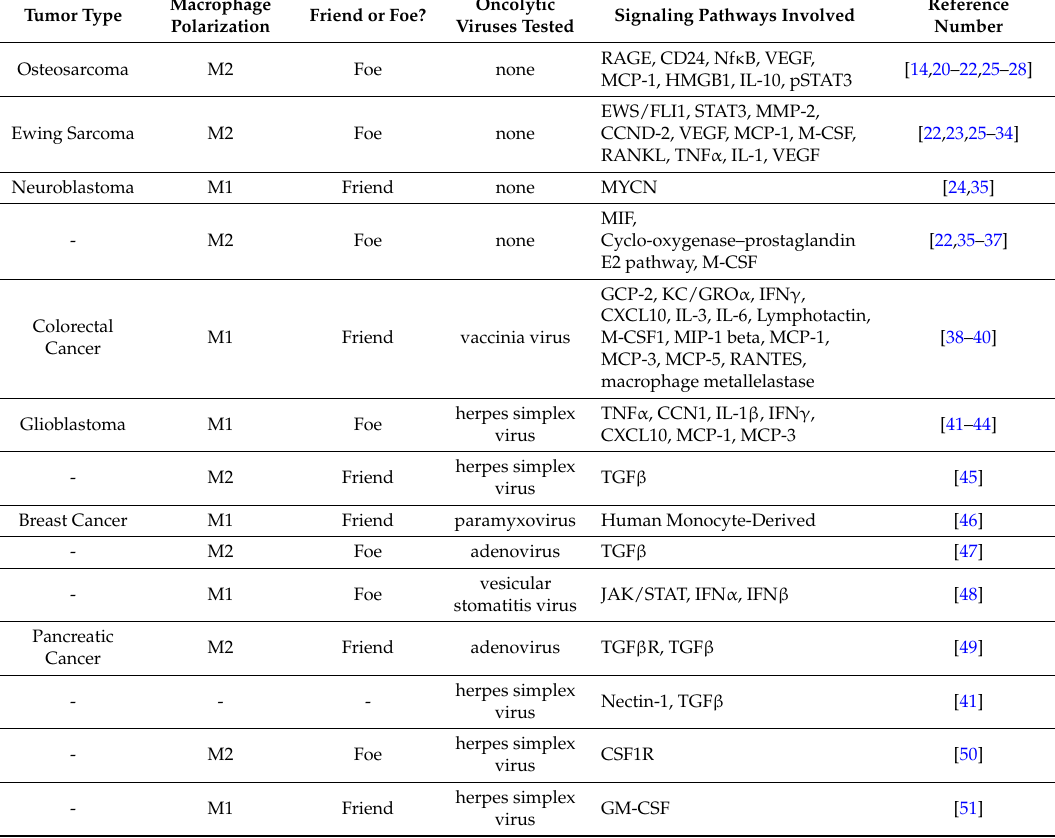
Table 1. Summary of macrophage friend or foe outcomes. While tumor-associated macrophages are generally associated with poor prognosis in human patients, the effect of tumor macrophages on oncolytic virus immunotherapy varies by the tumor type and the applied oncolytic virus vector. Despite similarities in the tumor macrophage effect on tumor progression between pediatric and adult cancers, there is a paucity of research investigating macrophage modulation with oncolytic virus immunotherapy in pediatric